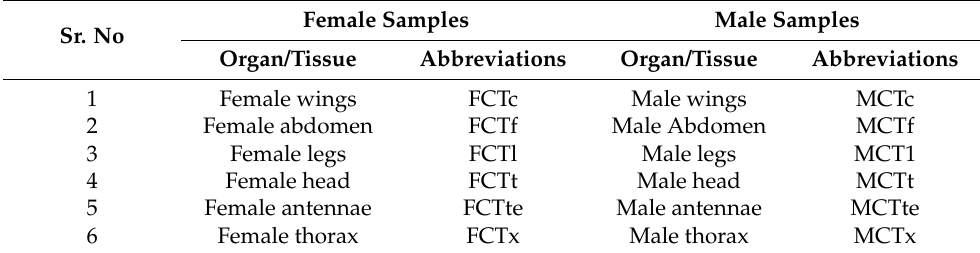
Table 1. Details of samples collected from different